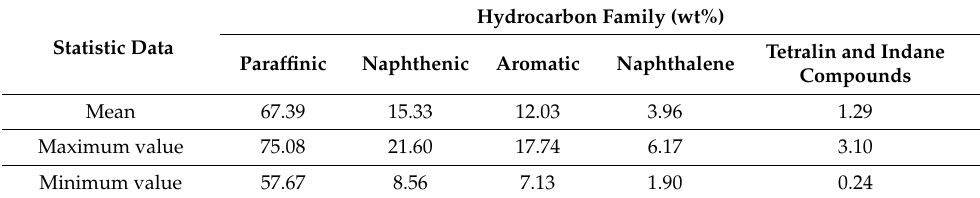
Table 2. Jet fuel composition by hydrocarbon